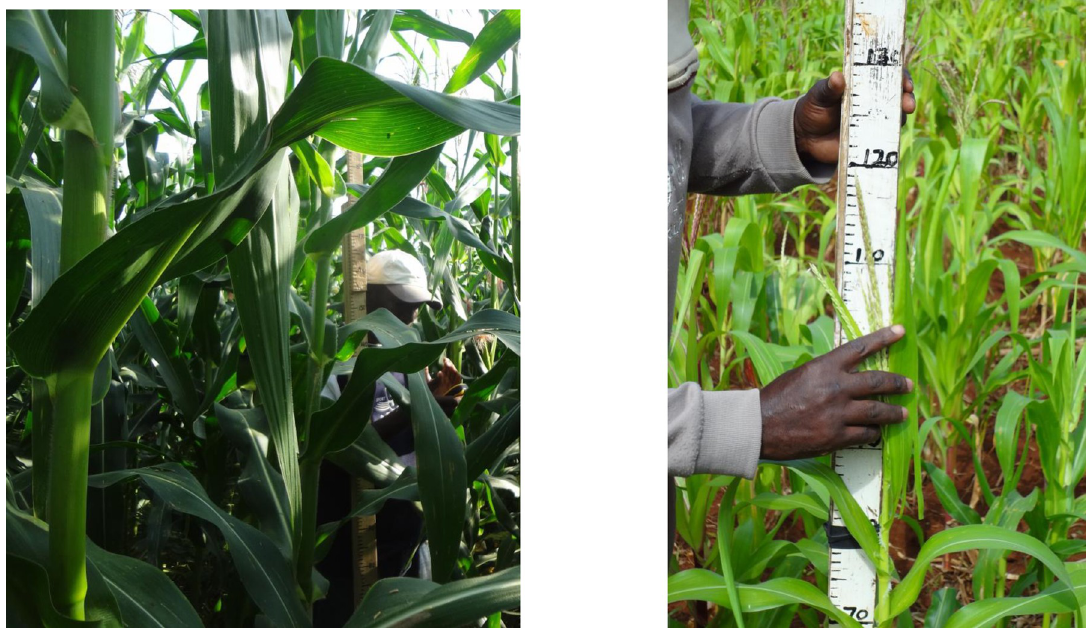
Fig 4. Photographs of a) good maize field, that is well managed and b) a poorly manage maize field, within the smallholder agroecosystems (Picture courtesy of Stephen M . Ichami ).